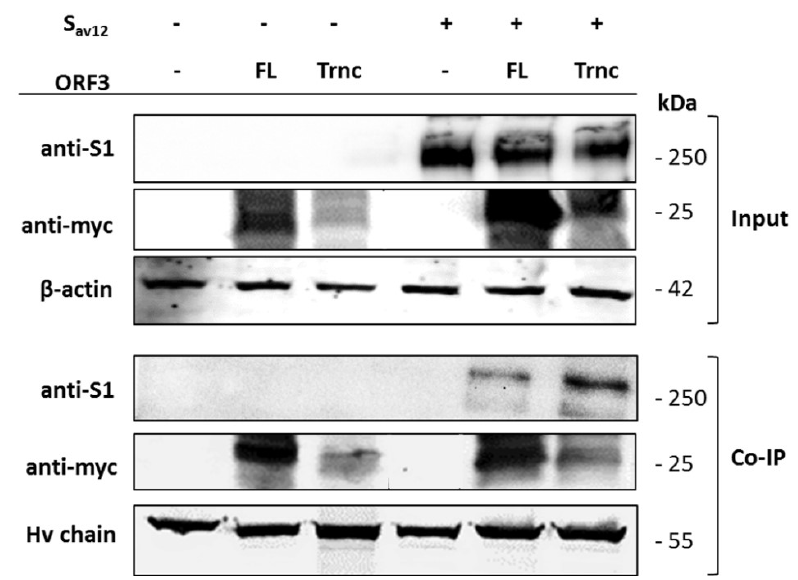
Figure 7. Co-immunoprecipitation of ORF3s and S proteins. HEK293T cells were transfected with pCAGGS plasmids expressing ORF3 (FL and Trnc) and S AV12 . Cells were harvested at 24 hpt and subjected for incubation with anti-myc agarose beads. The pulled-down proteins were stained with rabbit anti-myc and mouse anti-S1 antibodies specific for ORF3-myc and S proteins. β-actin and IgG-heavy chain (Hv-chain) were used as loading controls.